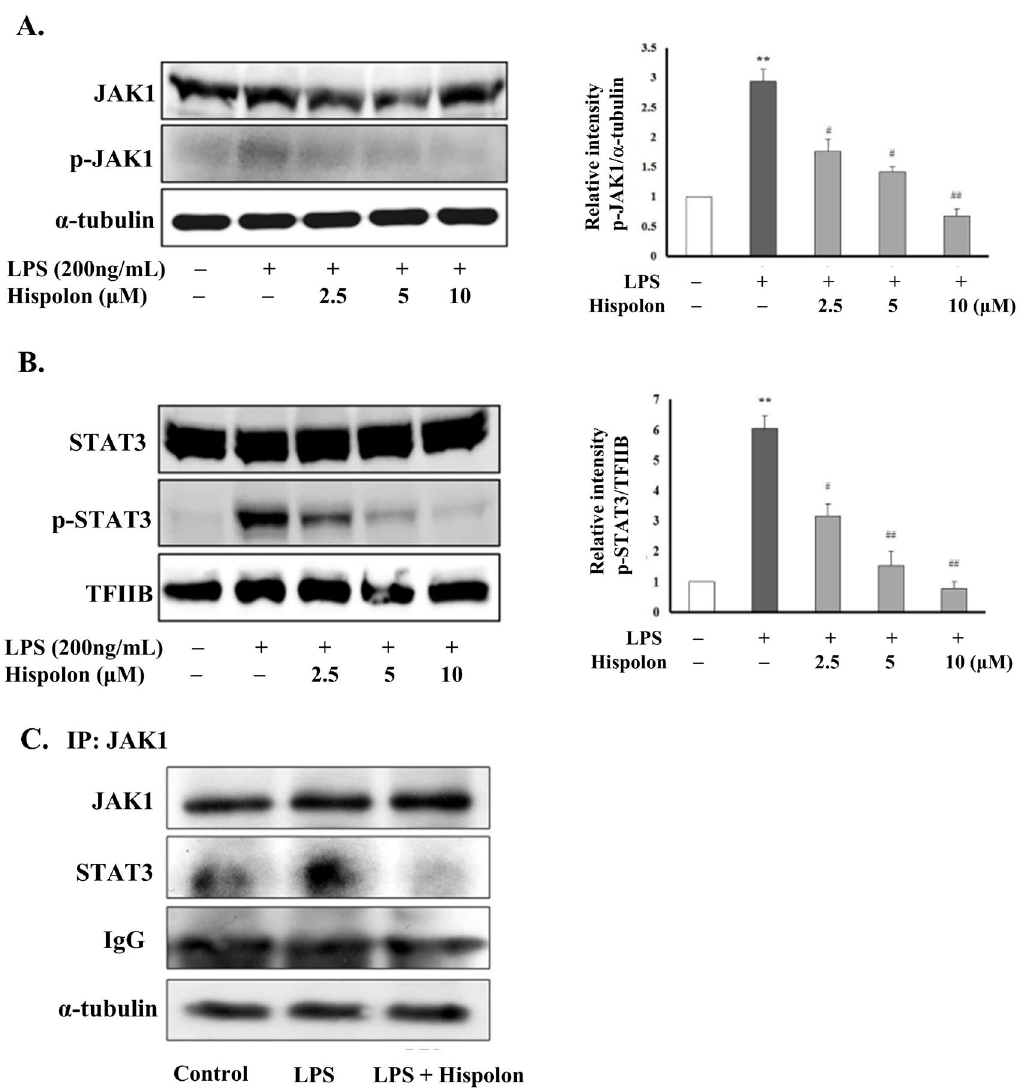
Figure 5. Hispolon suppressed JAK1/STAT3 signaling in LPS-induced RAW 264.7 cells. Cells were pretreated with hispolon for 1 h prior to LPS stimulation for 1 h. ( A , B ) Total and phosphorylated levels of JAK1 and STAT3 were measured in the cytoplasmic and nuclear fractions, respectively. ( C ) Whole-cell lysates were prepared, and a coimmunoprecipitation assay was conducted to identify JAK1 and STAT3 protein complexes. The data are presented as the means of three separate experiments performed in triplicate ( n = 3). The relative intensity of band in each blot was quantified using ImageJ software. Significance was analyzed using one-way ANOVA; ** p < 0.01, vs. control group; # p < 0.05 and ## p < 0.01, vs. LPS-treated group.